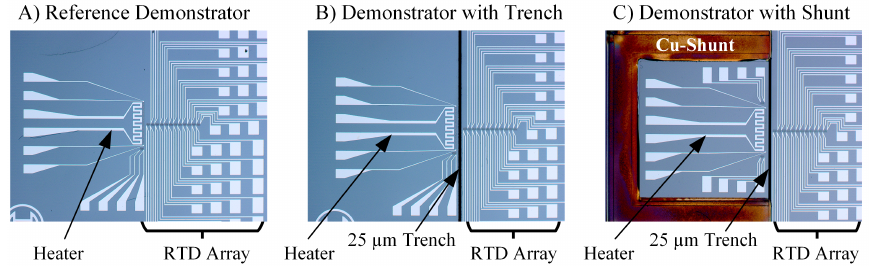
Figure 5. Microscope images of fabricated thermal demonstrators. ( A ) Reference demonstrators without any thermal management measure ( B ) Demonstrator with trench. ( C ) Demonstrator with trench and heat